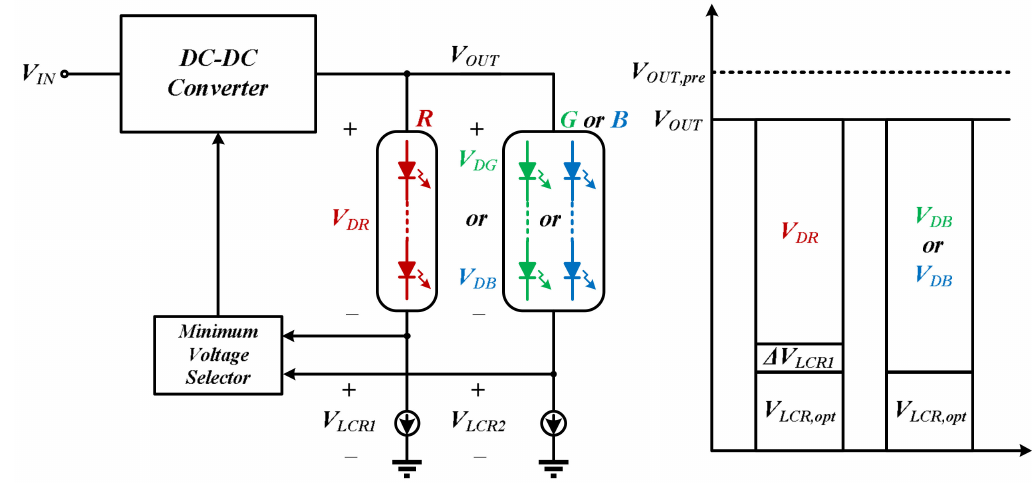
Figure 5. LED driver with adaptive driving voltage control